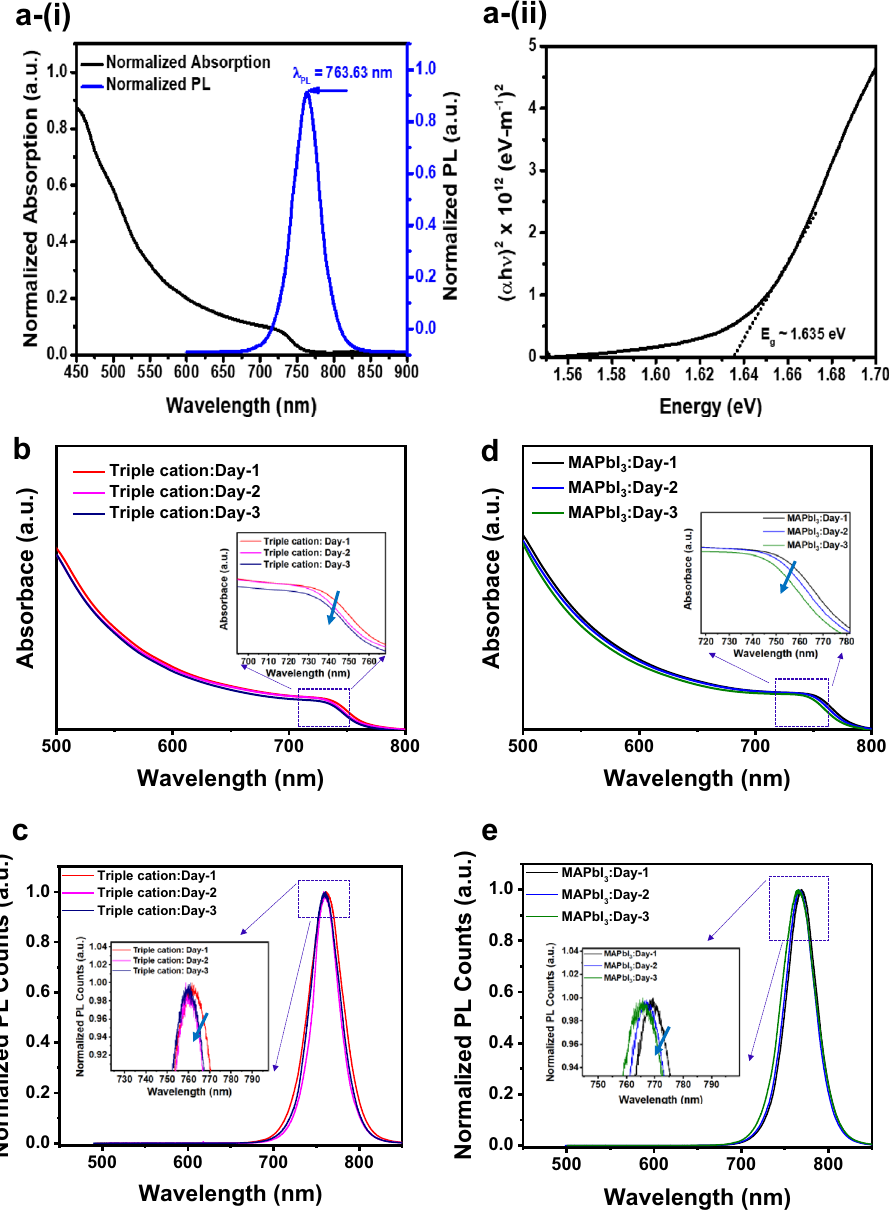
Figure 3. Material characterization conducted on the triple cation and MAPbI 3 absorbers. ( a – i ) UV–Vis absorption spectra and steady-state PL spectra of the triple cation perovskite film on normalized scale; ( ii ) Tauc- plot for determination of the optical bandgap of the triple cation perovskite film, revealing an E g ~ 1.63 eV. For the triple cation absorber, evolution of ( b ) absorbance spectra and ( c ) PL spectra with ambient exposure from day 1 to day 3. Insets in ( b , c ) represent the expanded scale spectra. For the MAPbI 3 absorber, evolution of ( d ) absorbance spectra and ( e ) PL spectra with ambient exposure from day 1 to day 3. Insets in ( d , e ) represent the expanded scale spectra. The ambient exposure conditions for the films were ~ 22 °C and ~ 50%